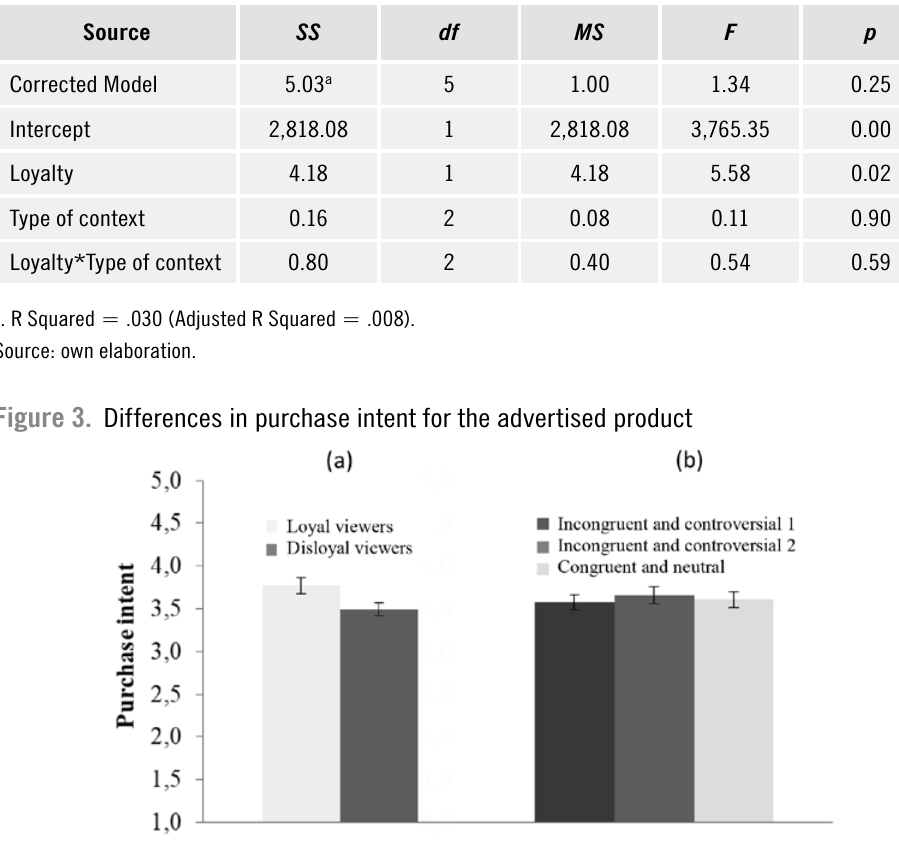
(a) Mean purchase intent of the advertised product among viewers loyal (n = 95) vs. disloyal (n = 127) toward program content. (b) Mean purchase intent of the advertised product among viewers who see the ad in incongruent and controversial context 1 (n = 68) vs. incongruent and controversial context 2 (n = 70) vs. congruent and non-controversial context (n = 84). Error bars denote standard errors around the